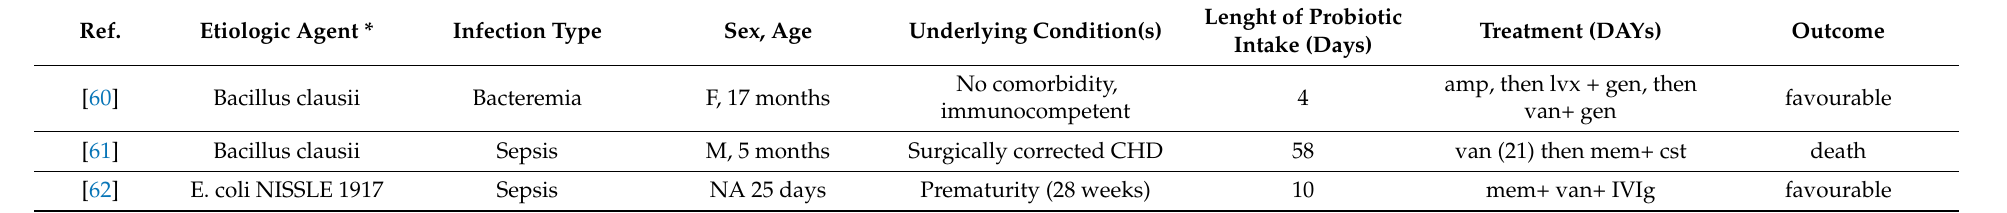
Table 4. Clinical and microbiologic features of 3 paediatric patients with other probiotic invasive infections after use of probiotics.